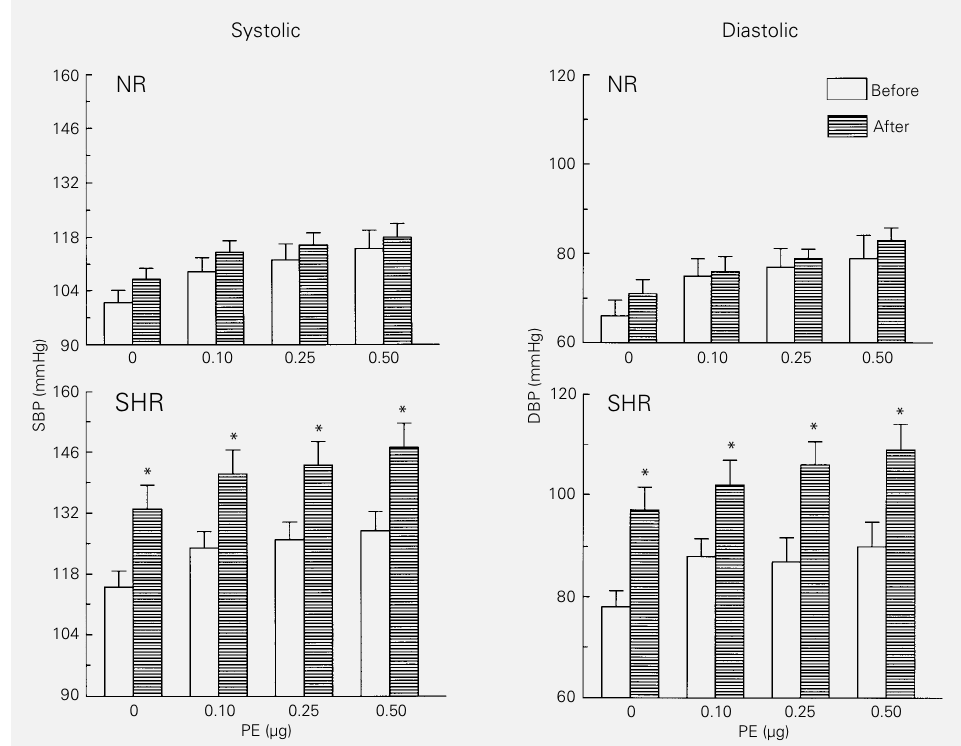
Figure 5 - Effects of increasing doses of phenylephrine (PE) on the systolic blood pressure (SBP) and diastolic blood pressure (DBP) of normotensive (NR) and hypertensive (SHR) rats before and after 1-h treatment with 1.8 (cid:181)g/kg ouabain. Column height in- dicates the mean and the bar the SEM. *P<0.05 for comparison between before and after oua- bain treatment